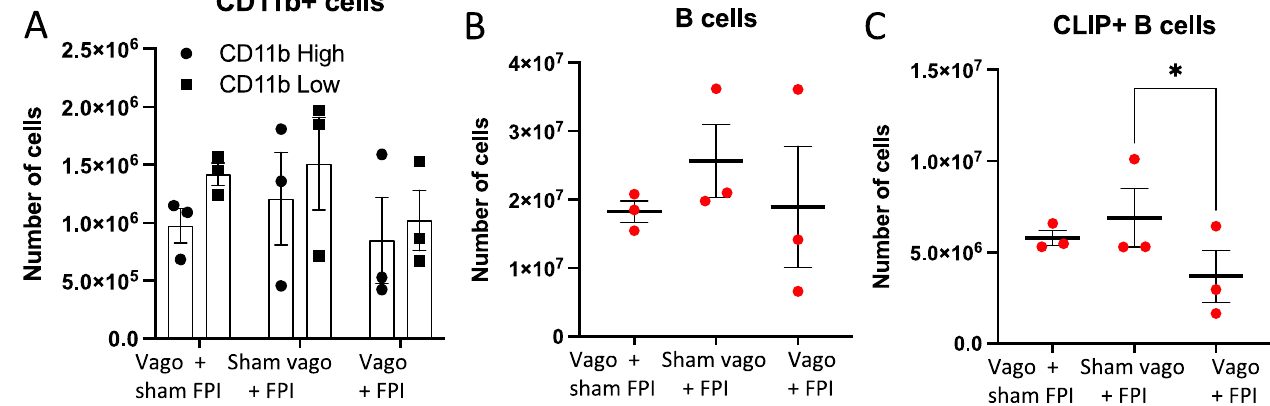
Figure 2. Influence of vagotomy on macrophages and B cells after FPI. In ( A ), comparison of the number of splenic macrophages stratified by high or low CD11b expression. No significant differences were observed between groups. In ( B ), quantification of the flow cytometric analysis of total splenic B cells also revealed no significant differences between groups. In ( C ), examination of CLIP+ B cells demonstrated that vagotomy prior to FPI (Vago + FPI) resulted in a significant decrease in CLIP+ B cells compared to sham vagotomy + FPI (Sham vago + FPI; * = p < 0.05). 2.3. T Cell and T Cell Subsets Are Influenced by Vagotomy and FPI Examination of the overall number of CD3+ T cells demonstrated a trend towards a difference ( p = 0.094), wherein vagotomy + FPI resulted in less T cells compared to vagotomy + sham FPI (Figure 3A). Significantly less CD4+ T cells were observed in the vagotomy + FPI group, compared to sham vagotomy + FPI ( p < 0.05; Figure 3B). A trend approaching significance ( p = 0.055) was also identified, showing increased T cells in the sham vagotomy + FPI compared to the vagotomy + sham FPI (Figure 3B). Analysis of CD8+ T cells showed that FPI + vagotomy caused a significant decrease in CD8 + T cells ( p < 0.03) compared to sham vagotomy + FPI (Figure 3C). Thus, it is possible that FPI induces an increase in CD4+ and CD8+ T cells, and the vagus nerve is involved in either the expansion and/or the extravasation of these T cells following TBI. Quantification of the number of CD4+CD25+ T cells revealed a trend ( p = 0.179) towards an increased number of cells in sham vagotomy + FPI compared to vagotomy + FPI (Figure 3D). No significant changes were observed for γδ T cells (Figure